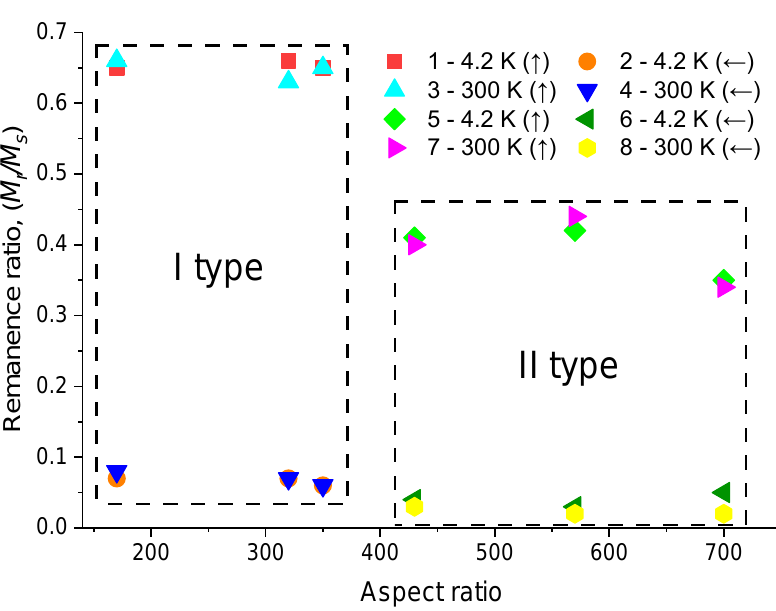
Figure 8. The squareness ratio M r /M s depending on the aspect ratio for two types of samples at 4.2 K and 300 K temperatures: 1, 2, 3, 4––the I type (Samples No. 1, 2, 3); 5, 6, 7, 8––the II type (Samples and 300 K temperatures: 1, 2, 3, 4—the I type (Samples No. 1, 2, 3); 5, 6, 7, 8—the II type (Samples No. No. 4, 5, 6). 4, 5,